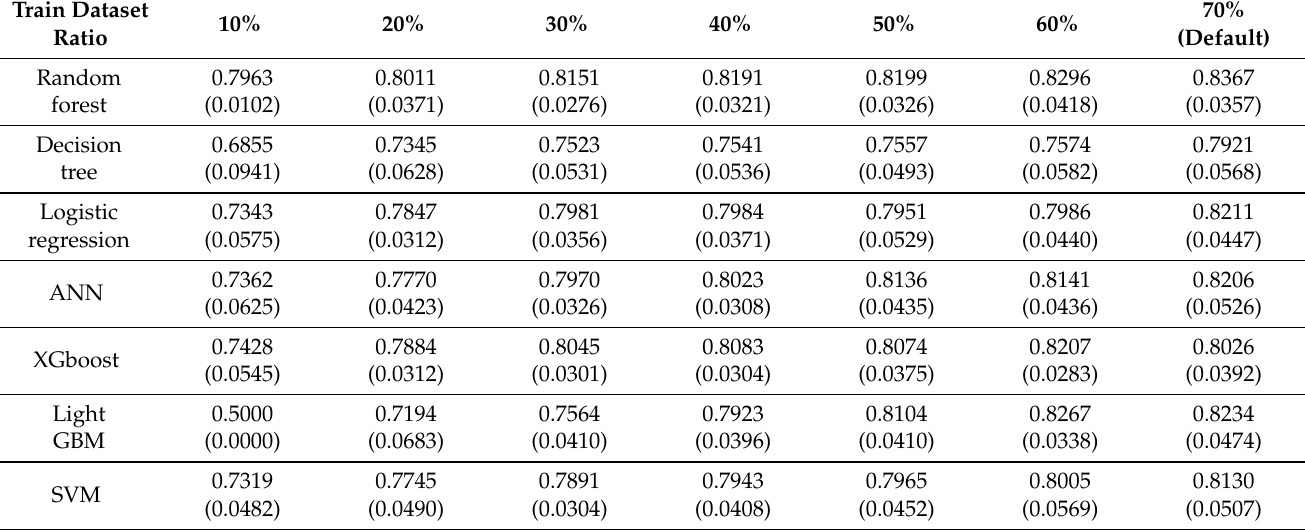
Table 17. Changes of liver cancer risk association model’s performance according to the number of train